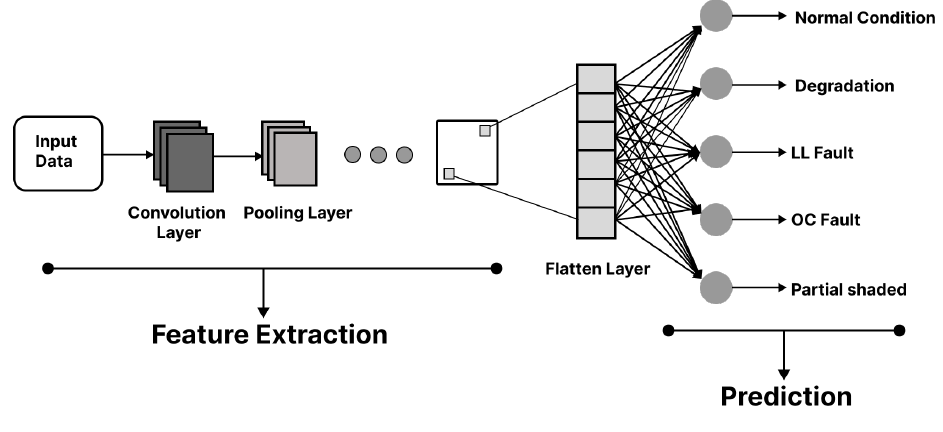
Figure 4. The CNN architecture.